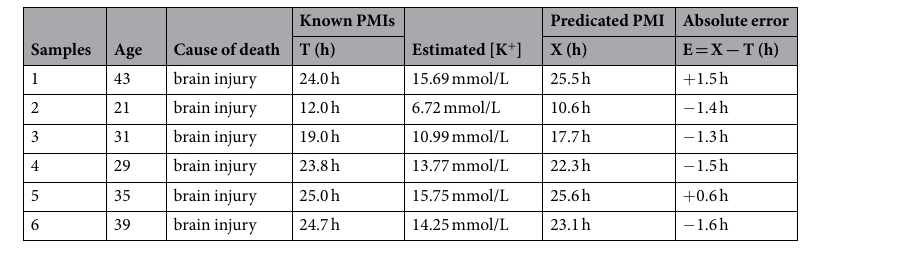
Table 1. Comparison of the estimated PMIs with the true